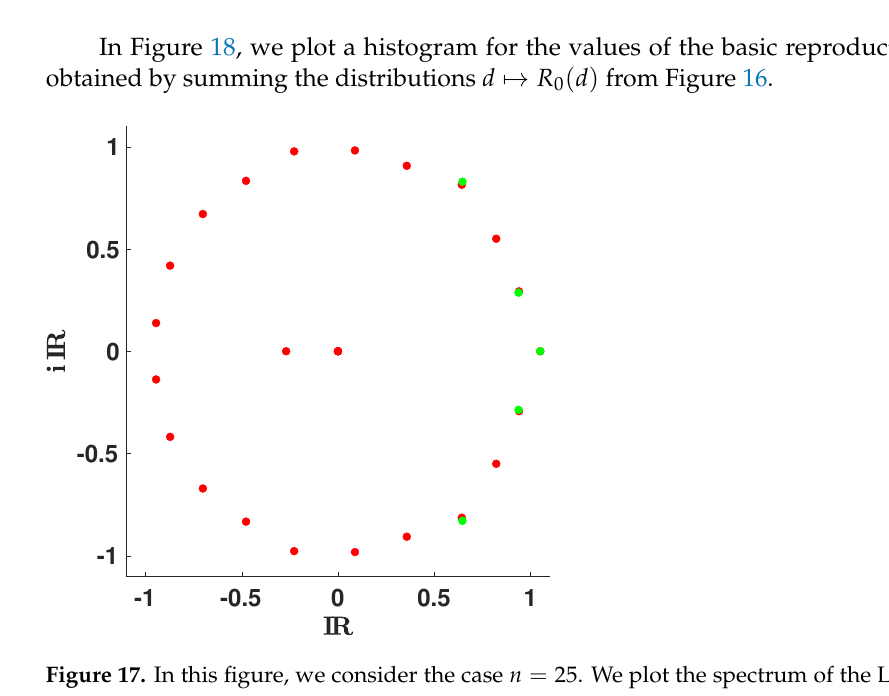
Figure 17. In this figure, we consider the case n = 25. We plot the spectrum of the Leslie matrix L (red dots) when d (cid:55)→ R 0 ( d ) corresponds to the average distribution (i.e., the red curve in Figure 15).